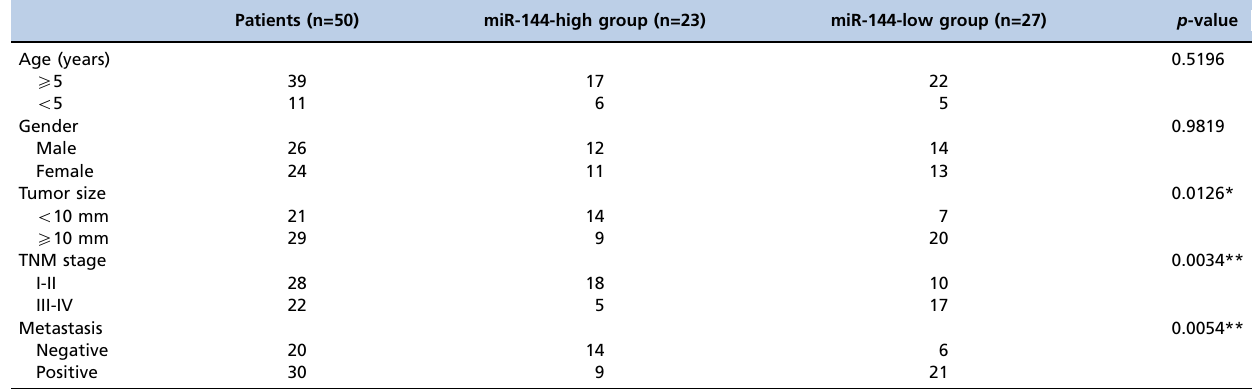
Table 1 - Clinical information of retinoblastoma (RB)